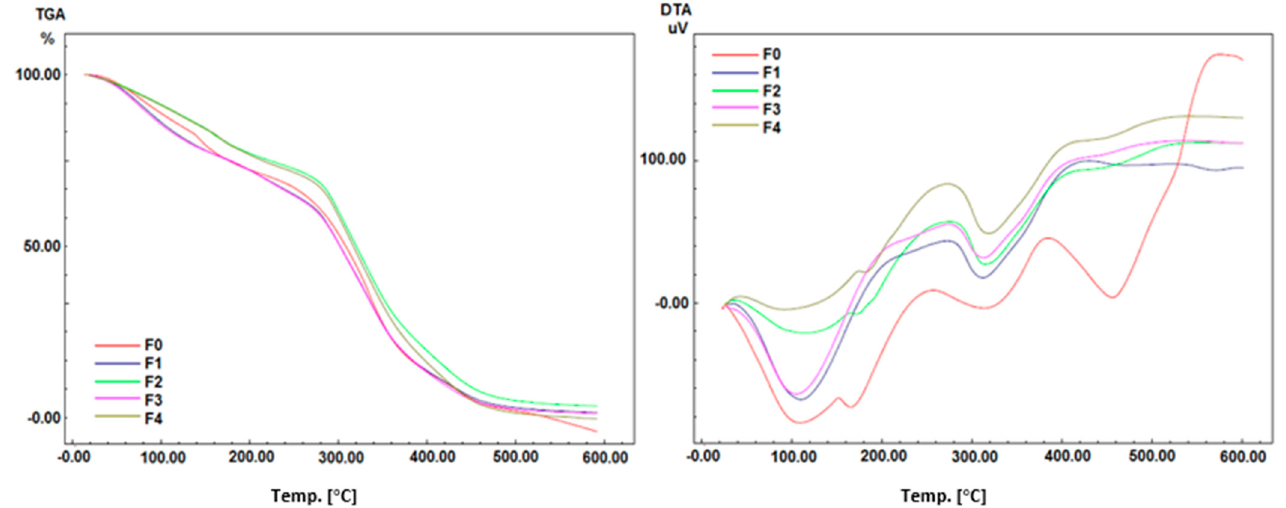
Figure 9. Analysis of TGA and DTA of Polyvinyl alcohol/Corn starch/Patchouli oil/Hydrogel films